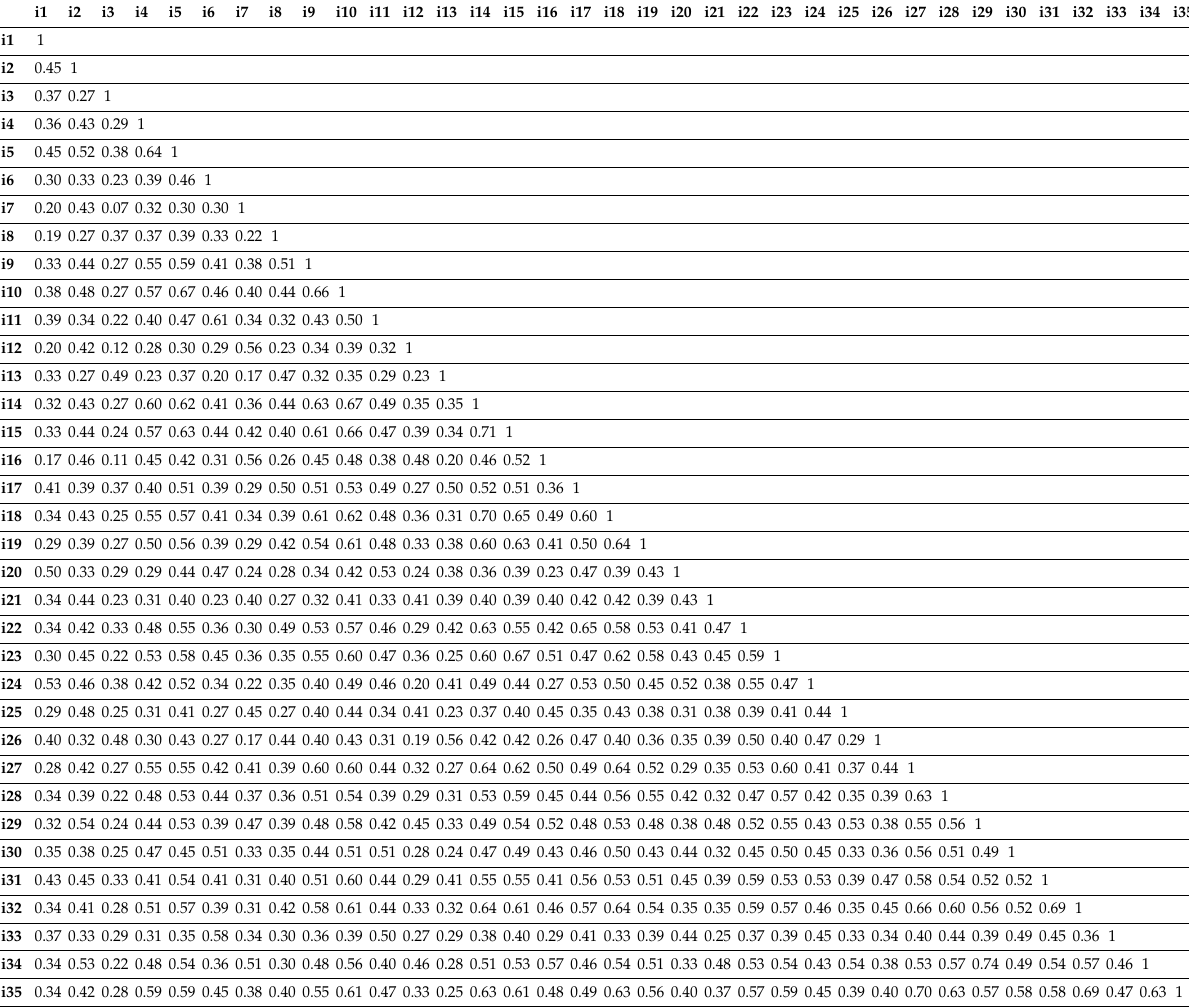
Table 1. Polychoric correlation matrix for the